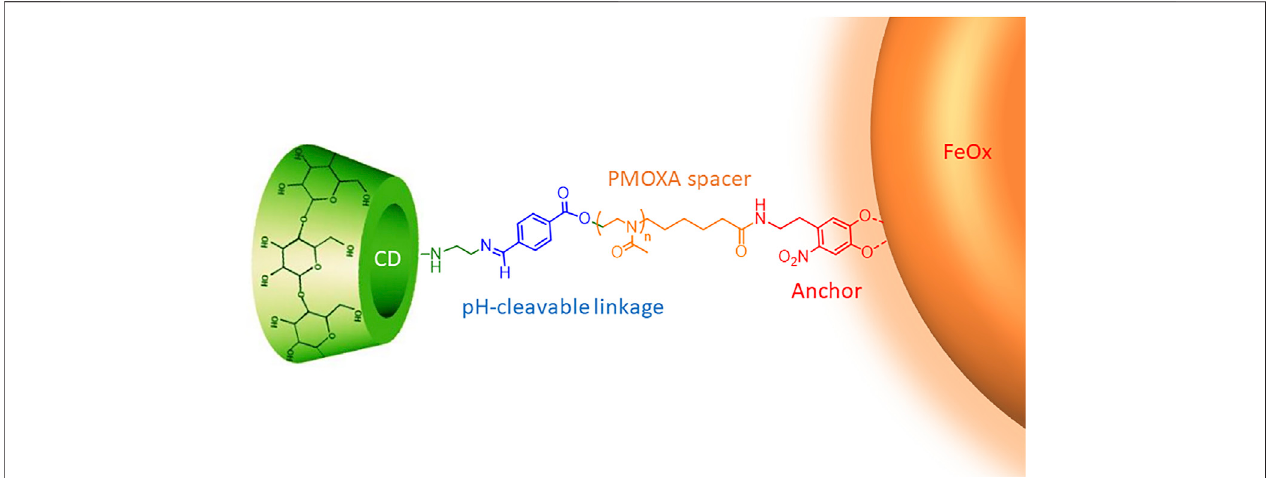
FIGURE 1 | Schematic representation of the CySPION ’ s